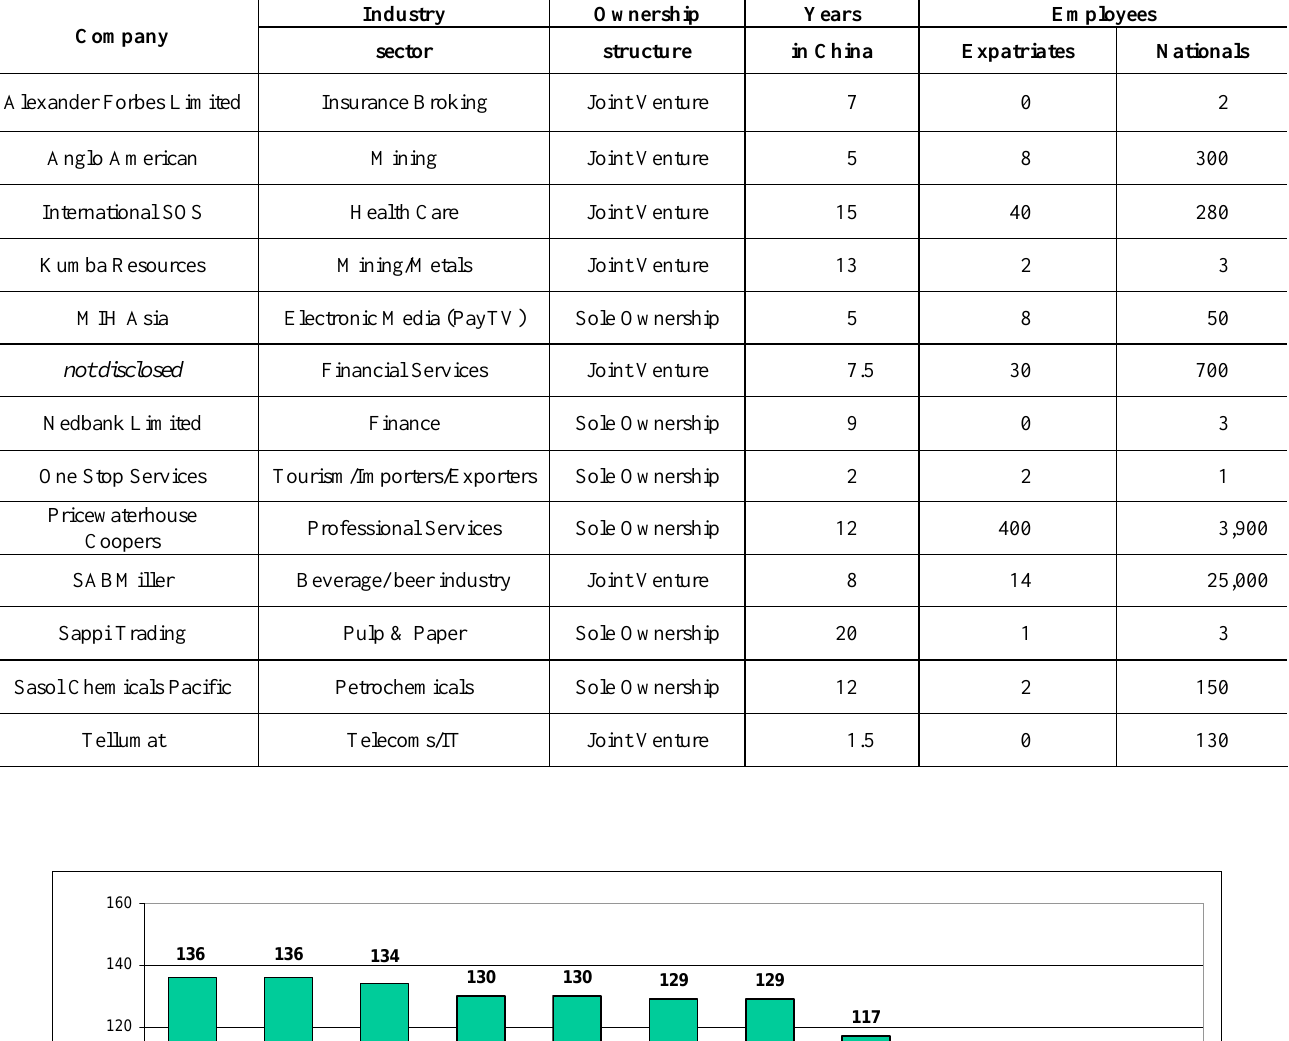
Table 1: Descriptive details of companies represented by respondents